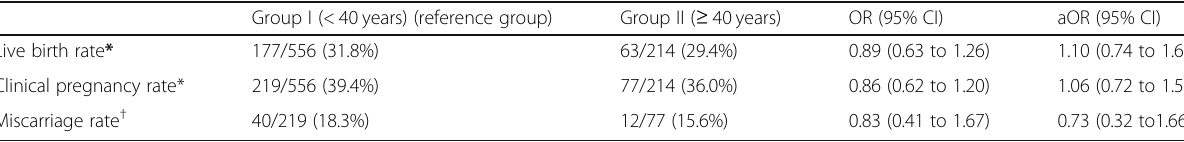
Table 2 Comparison of clinical outcomes between group I (male partner age < 40 years) and group II (male partner ≥